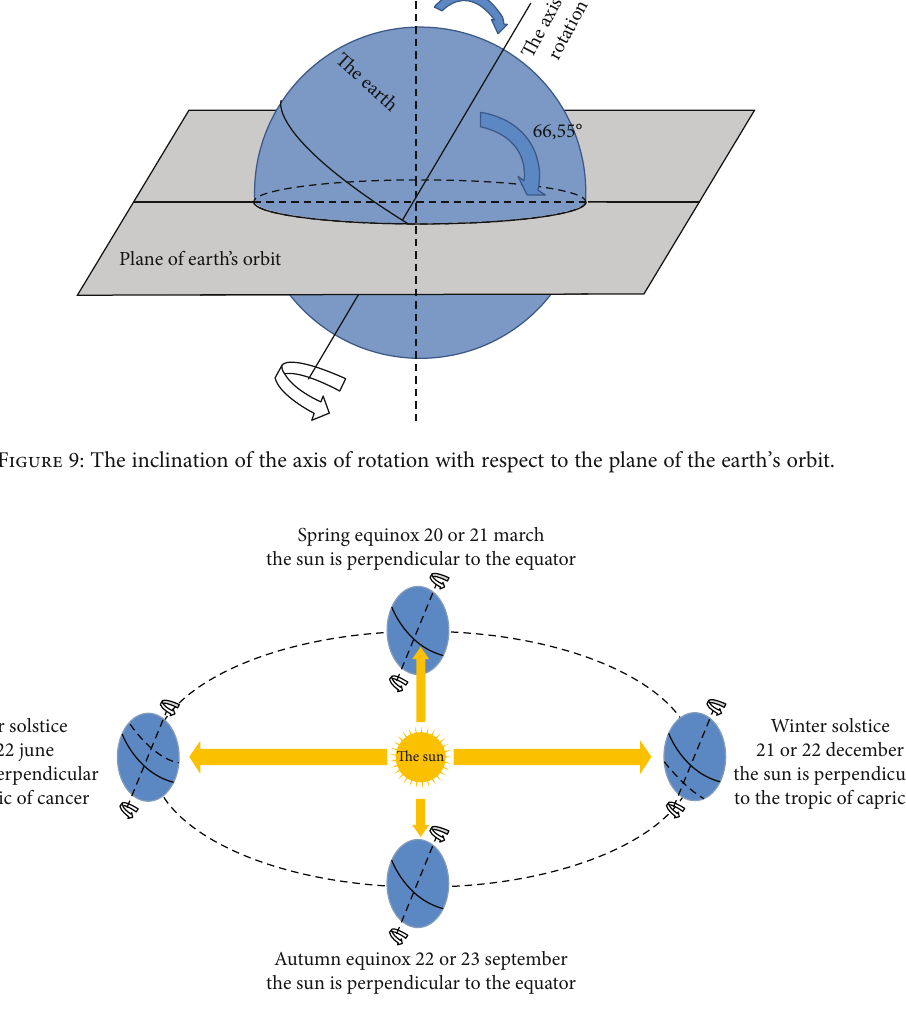
Figure 10: Movement of the earth around the